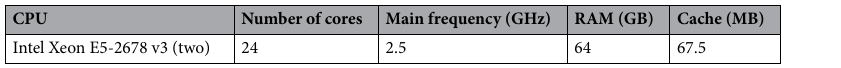
Table 3. Workstation